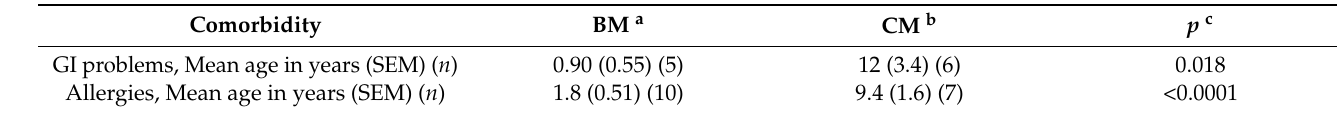
Table 10. Age of commencement of GI problems and allergies in FXS study population as a function of exclusive breast milk versus cow milk